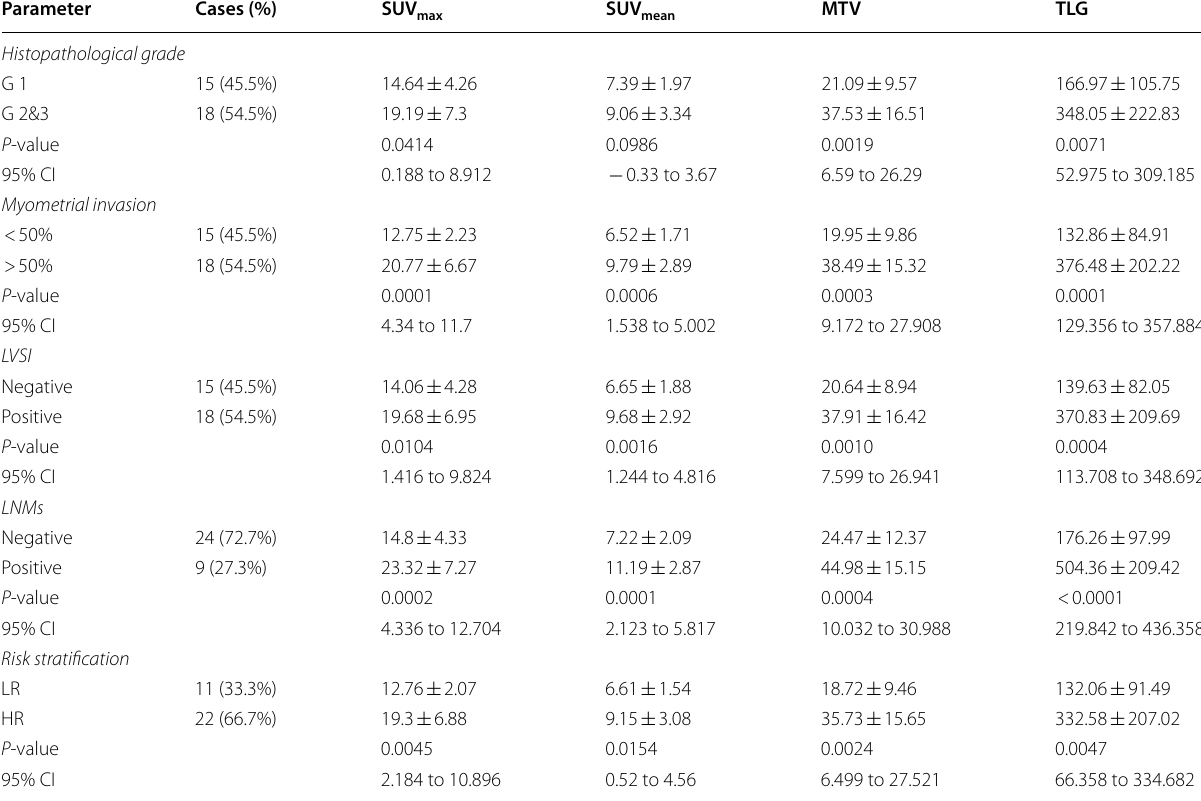
Table 2 PET-CT indices and EC risk